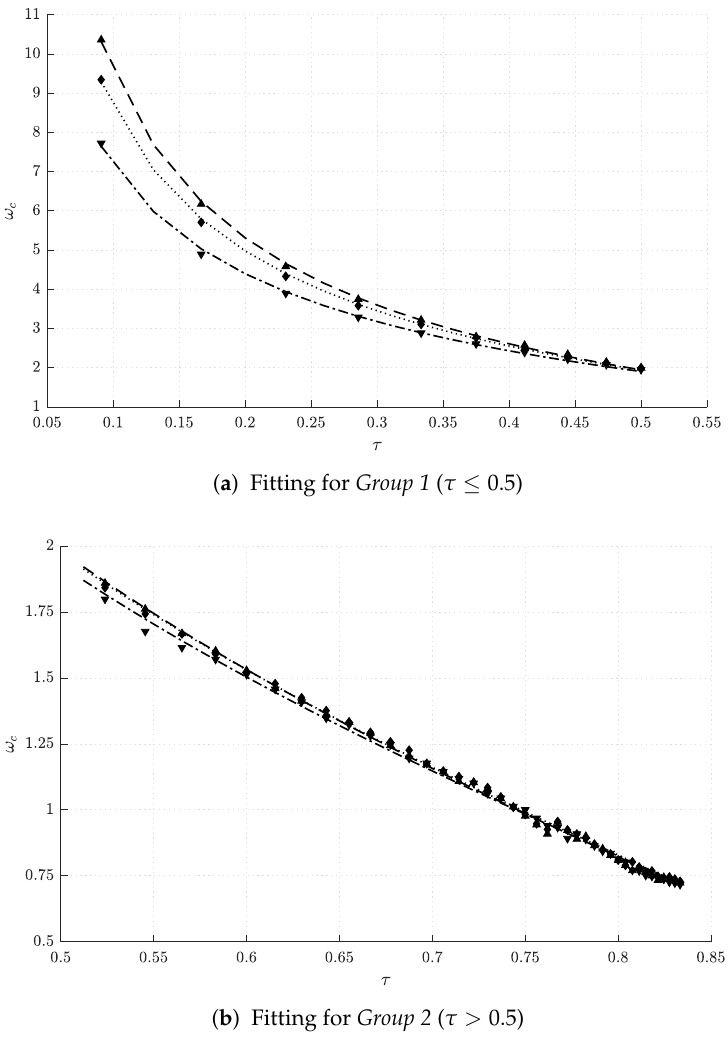
Figure 10. Tuning for LADRC controller bandwidth. Markers indicate the optimal solutions UP ( (cid:78) ), NS ( (cid:7) ), and BP ( (cid:72) ). Lines are the fitting functions for robustness levels ε low ( −− ), ε med ( · · · ), and ε high (- ·